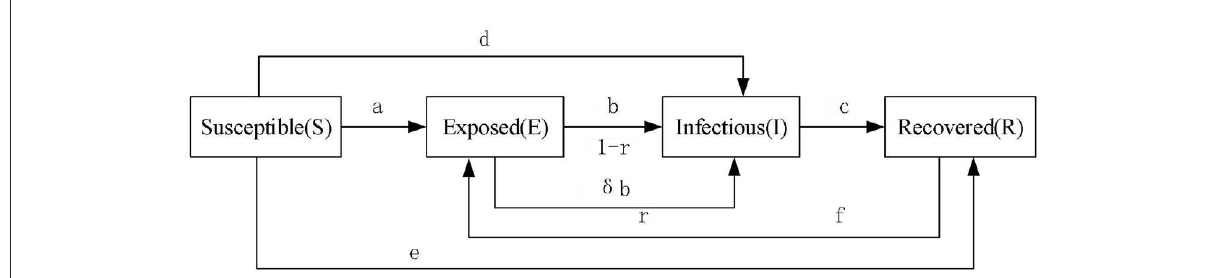
FIGURE1 Conceptual model of propagation process of unsafe psychological state of construction workers.